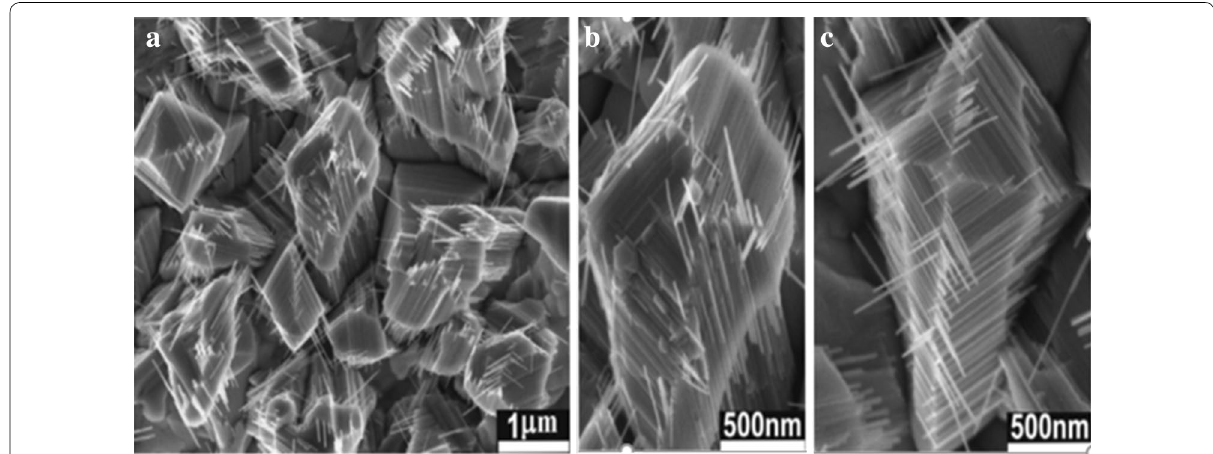
Fig. 5 a Low magnification SEM images of Mn 3 O 4 nanostructures/nanowires. b , c High magnification SEM images of Mn 3 O 4 nanostructures/ nanowires